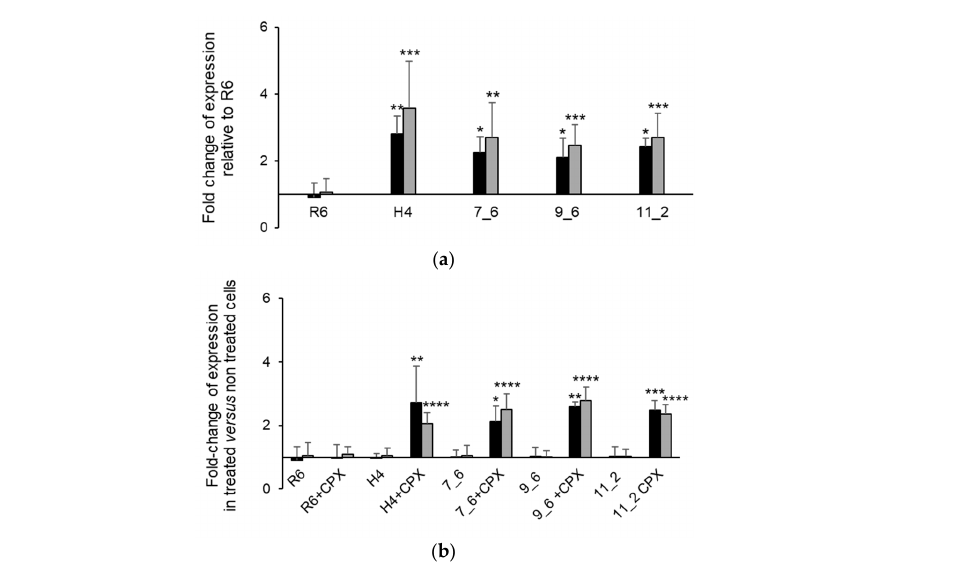
Figure 5. CPX induces patAB expression in SPN. Strains were cultured until an OD 620 = 0.2 and treated with 30 × MIC of CPX or non-treated for 1 h. MIC values considered for each strain were those detailed in Figure 4b. Total RNA was extracted and used in RT-qPCR. Fold-change of patA (black) and patB (gray) transcript levels were determined using the ΔΔ CT method. ( a ) Transcript levels on each strain relative to R6 in the absence of CPX; ( b ) transcript levels in treated versus non-treated cultures for each strain. Values shown are the mean of at least three independent replicates ( ± SD). Statistical significance relative to the reference condition on each panel was tested by the t -test with significant data points being highlighted by asterisks (* p < 0.05; ** p < 0.01; *** p < 0.001; **** p < 0.0001).